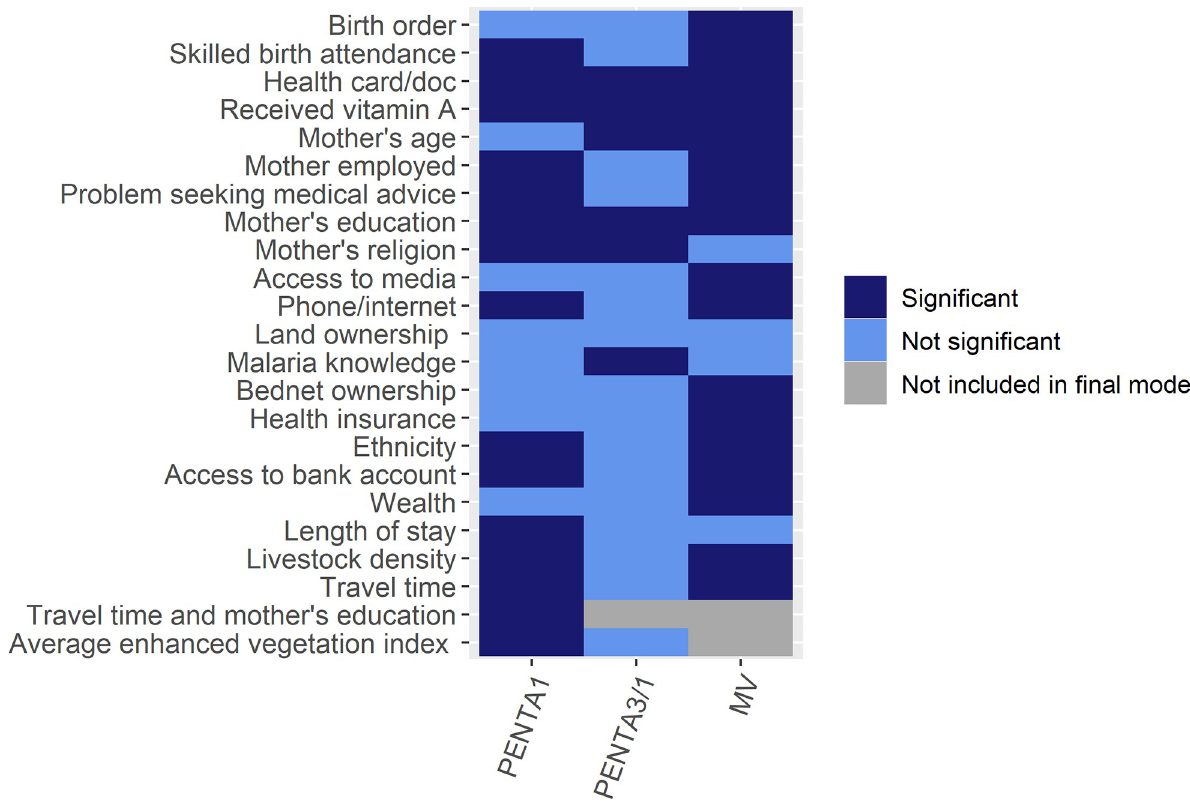
Fig 4. Summary of factors predictive of PENTA1, PENTA3/1 and MV vaccinations including the interaction term for PENTA1.